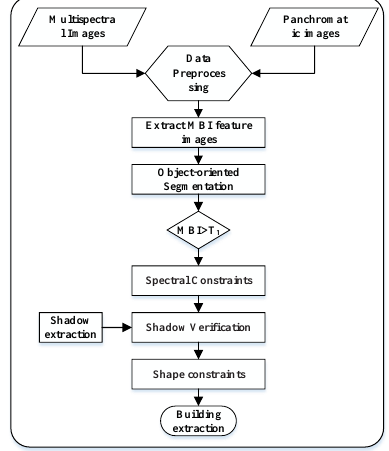
Figure 2. Flow chart of the proposed building extraction framework